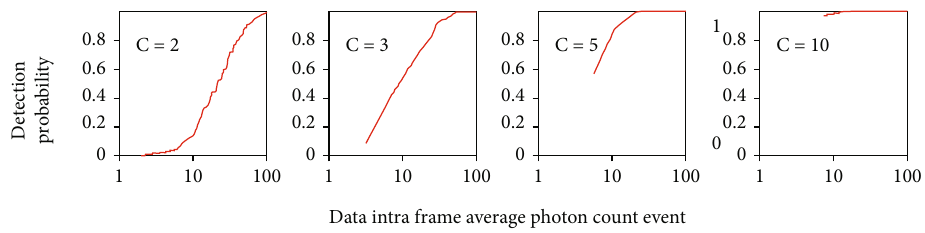
Figure 6: Relationship between detection probability and average photon-counting events inside the data frame. Table 1: E ff ect analysis on signal detection for photon counting under given